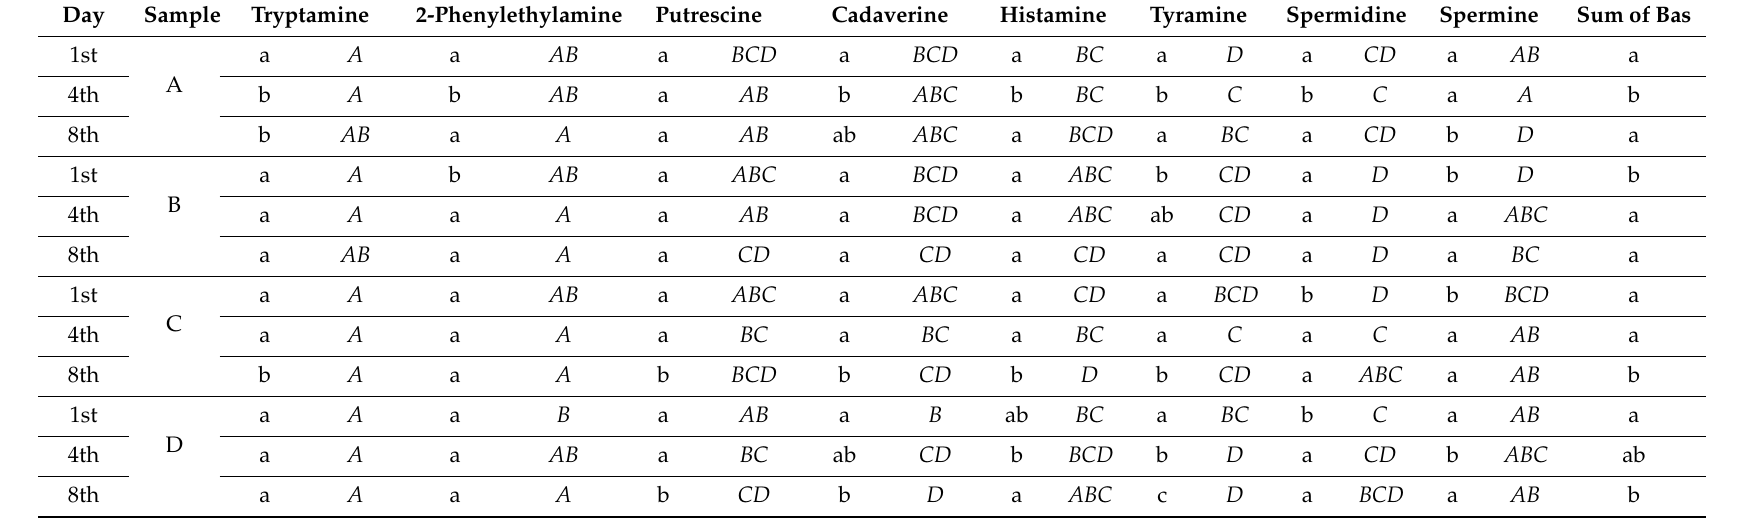
Table 3. Statistically significant di ff erences ( p < 0.05) for a particular biogenic amine (lower case “a”, “b” in columns) depending on the sampling day and between biogenic amines (capital letters “ A ” to “ D ” in italic in rows) for the sampling day are given.